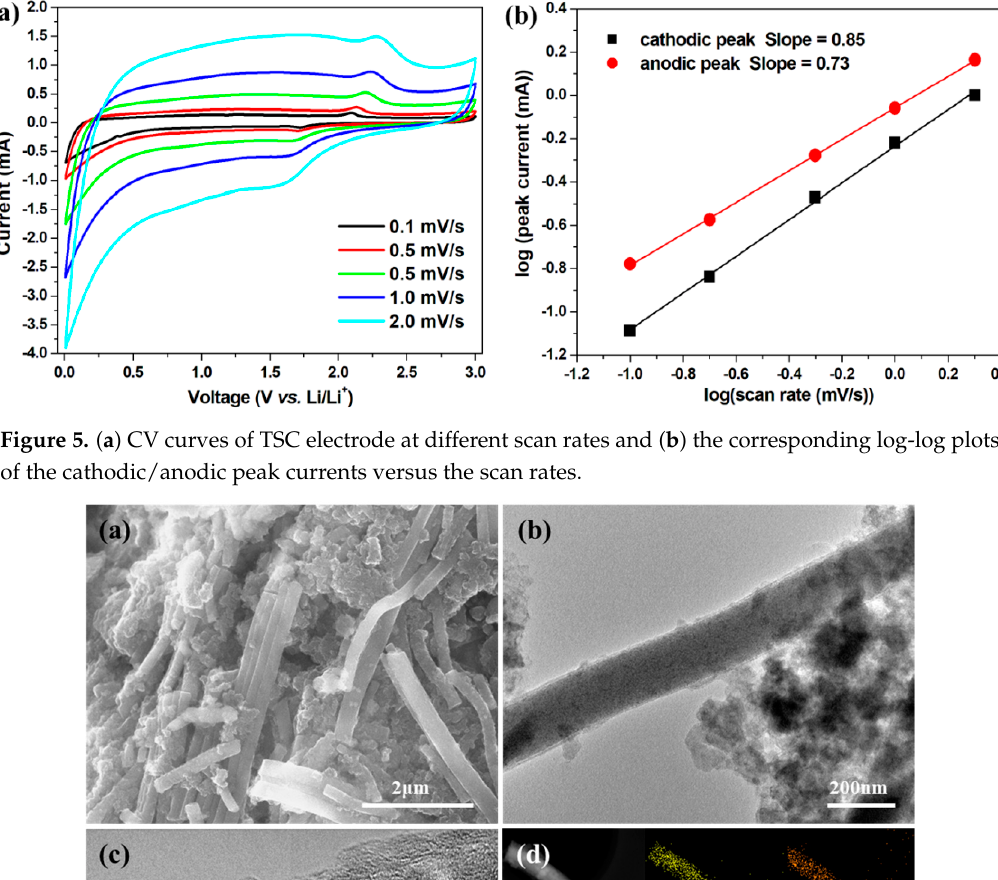
Figure 5. ( a ) CV curves of TSC electrode at different scan rates and ( b ) the corresponding log-log plots of the cathodic/anodic peak currents versus the scan rates.